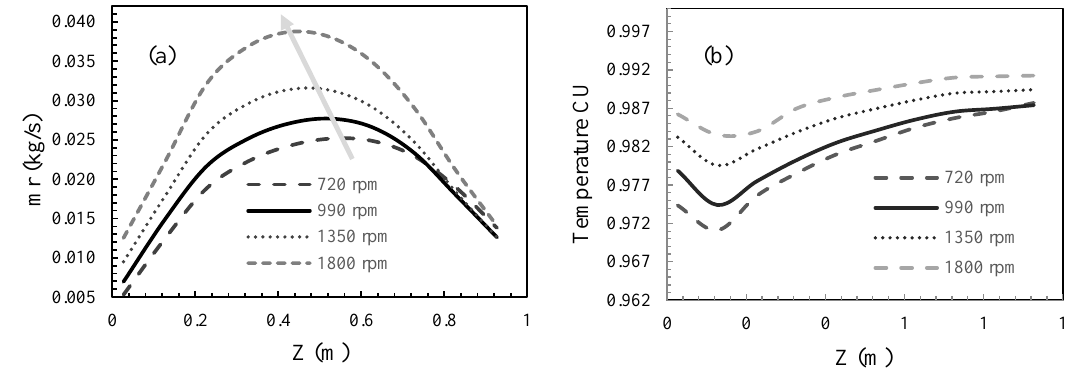
Figure 16. Mass recirculation ( a ) and temperature CU ( b ) at several heights of the process chamber. The mass recirculation could be related to the thermal homogeneity inside the chamber. To do